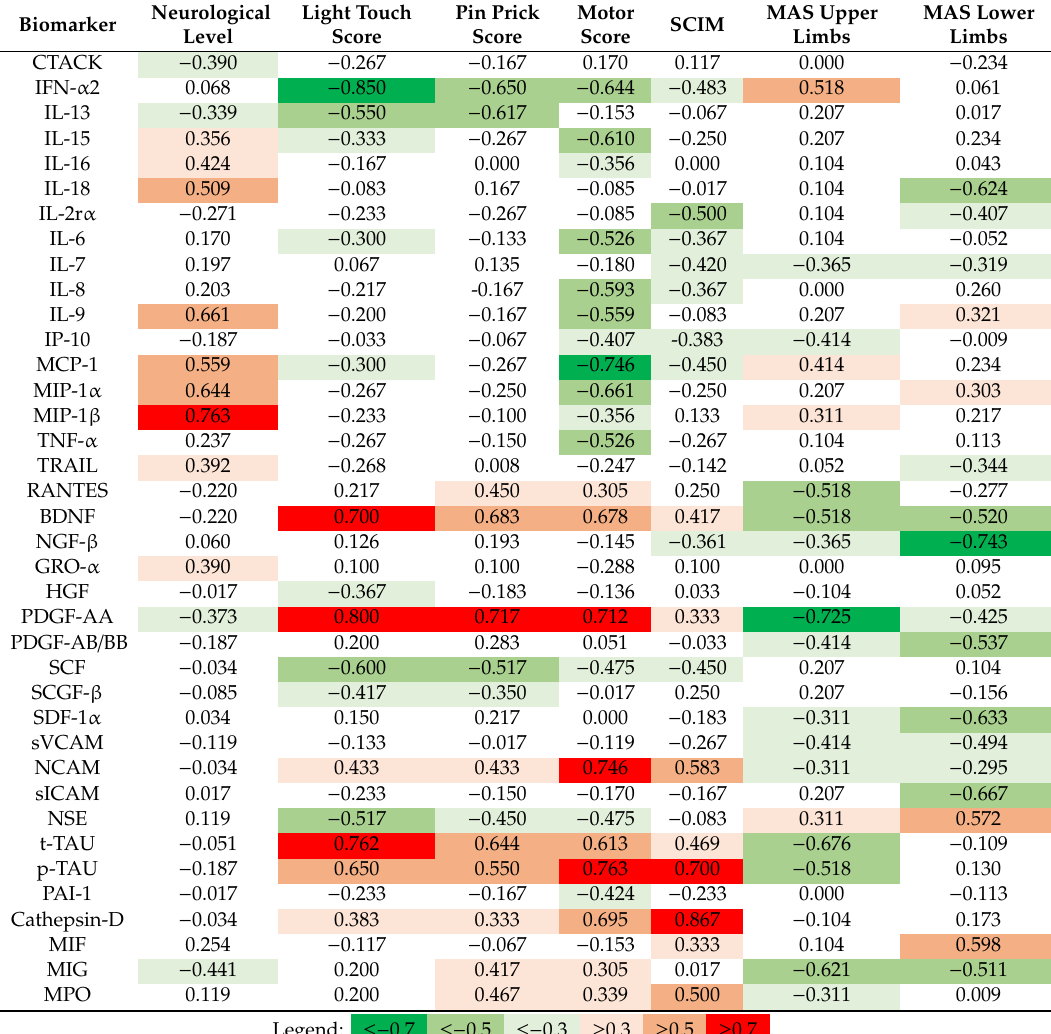
Table 3. Spearman’s correlation coe ffi cients between biomarkers and rating scales at discharge. The heat map is in red for positive correlations and green for negative correlations. The color saturation is proportional to the strength of the associations between variables.